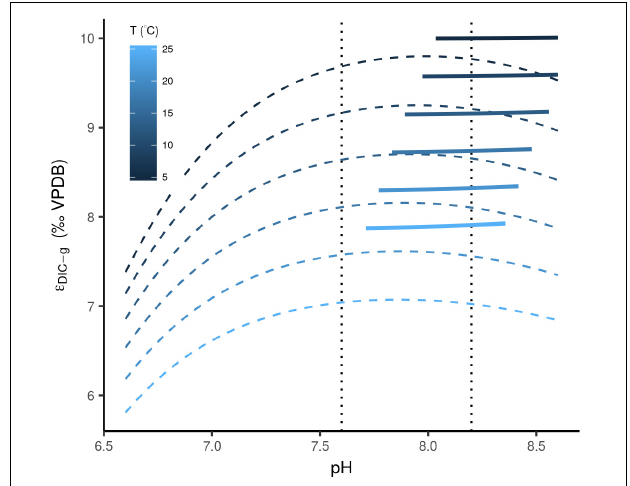
FIGURE 5 | Calculated equilibrium fractionation, after Zhang et al. (1995), between DIC and CO 2 in the air (thin dashed lines), based on the concentrations of aqueous carbon species, and (cid:15) DIC − g , based on an empirically derived relationship (thick lines). Values are plotted over pH and temperature ranges representative for aquatic environments. Note, that the empirically obtained (cid:15) DIC − g are only plotted for fCO 2 − 3 values in the range of 0.05 and 0.2. The vertical stippled lines depict the predicted range of pH change over the last 100 My (Tyrrell and Zeebe,